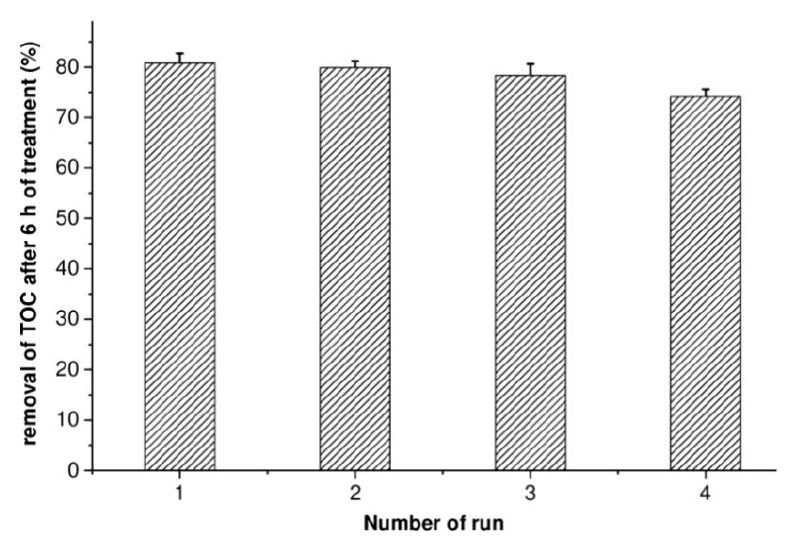
Figure 4. Stability of the catalytic activity of TiO 2 /Fe 3 O 4 -CS(2) beads.